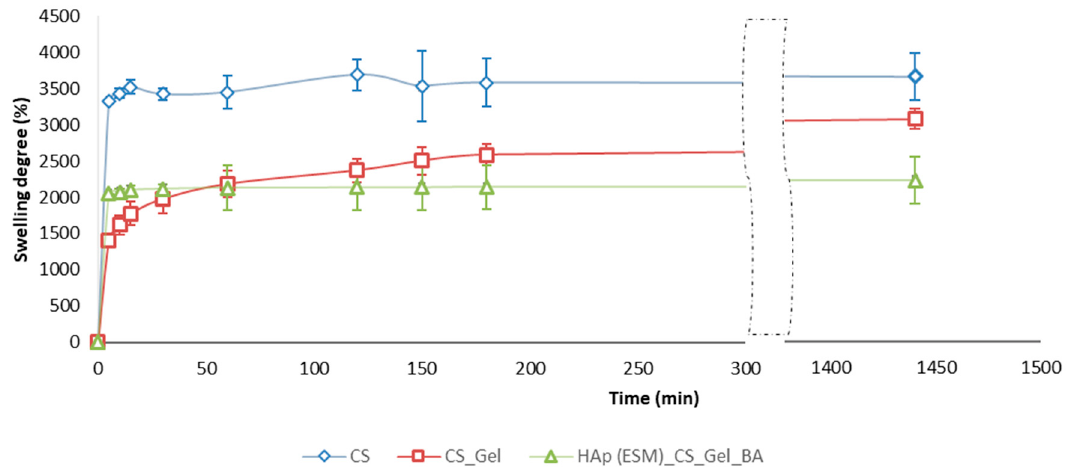
Figure 10. SBF swelling degree evaluation (presented as mean ± S.D. of three replicates)